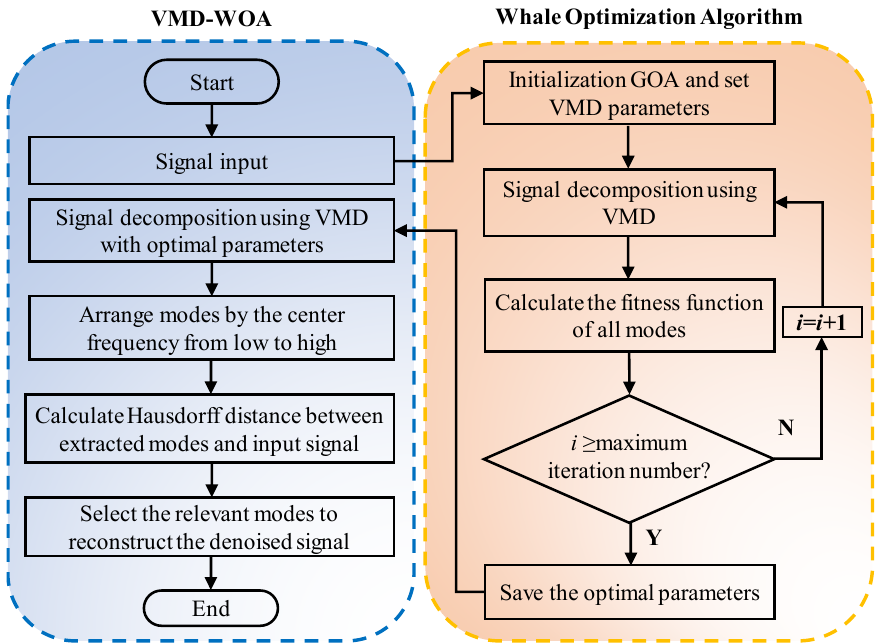
Figure 1. Flow chart of the proposed algorithm .